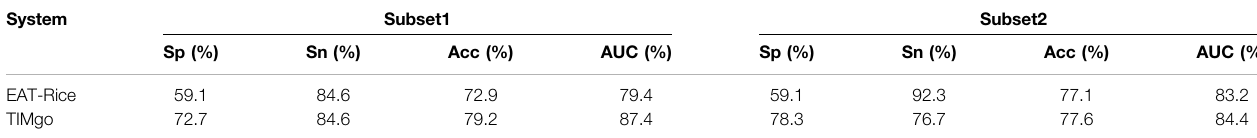
TABLE 7 | Comparison of TIMgo and EAT-Rice with independent-testing evaluation. System Subset1 Subset2